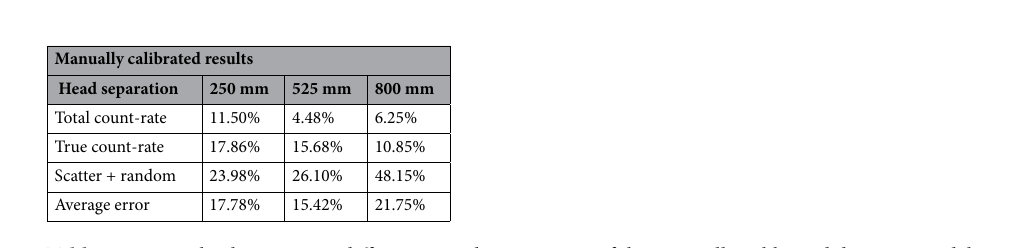
Table 5. Mean absolute percent differences in the count rate of the manually calibrated digitizer